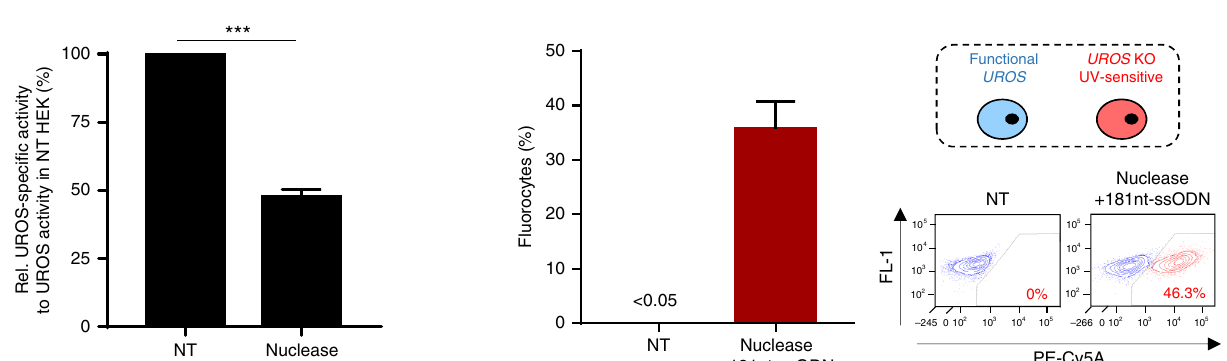
Fig. 2 Nuclease-mediated HDR is associated with predominant indels leading to impaired UROS functionality. a (Left) Scheme of SacI -digested PCR products obtained for alleles with or without HDR. (Center) Illustrative RFLP analysis of non-transfected HEK293T cells (NT) or transfected with nuclease only or co-delivered with the 181nt-ssODN template. (Right) HDR frequency induced by nuclease and a 181nt-ssODN ( n = 5). b (Left) NGS analysis of allelic outcomes and associated HDR/indel ratio following transfection of HEK293T cells with nuclease and 181nt-ssODN. (Center) Frequencies of reads carrying either insertion or deletion. Region spanning sgRNA sequence is highlighted in grey. (Right) Most common observed alleles (with frequencies ≥ 1%) aligned on the sgRNA sequence. HDR modi fi cation in blue and indels in red. c (Left) Quanti fi cation of UROS-speci fi c activity from HEK293T cells NT or transfected with nuclease and 181nt-ssODN ( n = 3). Values are normalized with NT cells. (Right) Fluorocyte frequencies and illustrative fl ow cytometry results from NT or HEK293T cells transfected with nuclease and a 181nt-ssODN ( n = 5). Blue and red dots (and associated percentages) depict non- fl uorescent cells and fl uorocytes, respectively, with type-I porphyrin accumulation. Results are presented as mean ± SEM. The data are from independent experiments. Statistical signi fi cance is inferred on raw data using two-tailed unpaired t test for UROS-speci fi c activity. *** p < 0.001. For a , c , source data are provided as a Source data fi